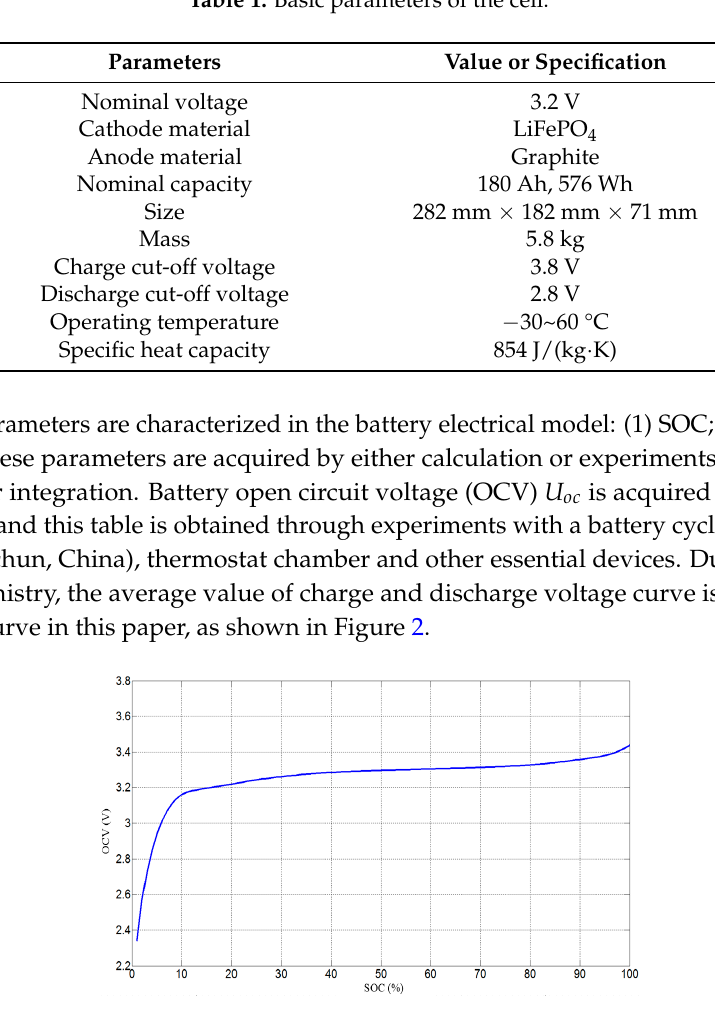
Figure 2. Cell SOC-OCV curve. SOC: state-of-charge. OCV: open circuit voltage.